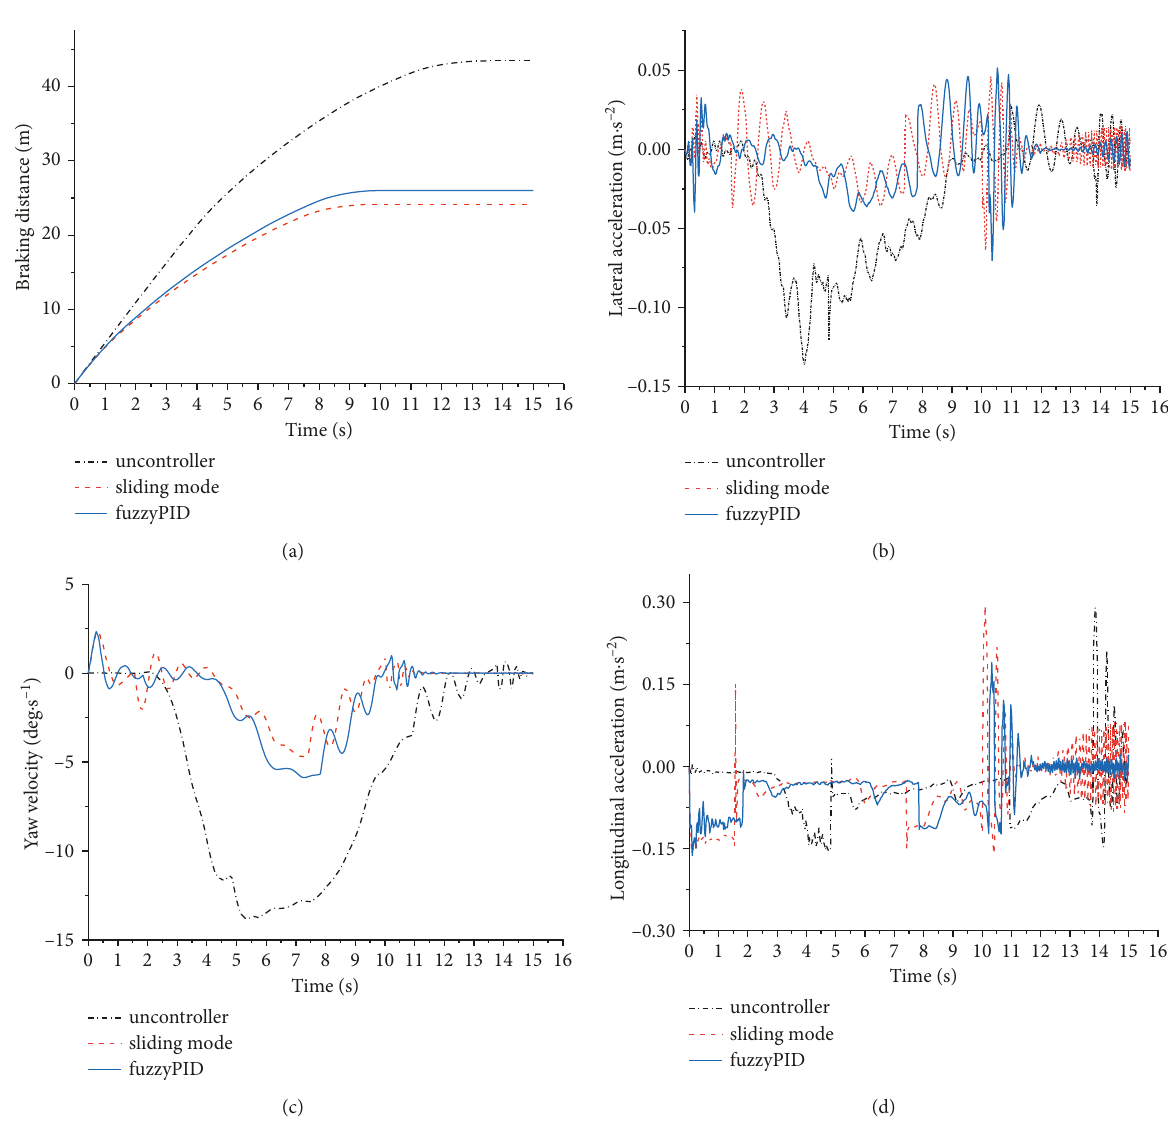
Figure 16: Simulation comparison diagram of different controls in curve driving with u � 0.5. (a) Braking distance. (b) Lateral acceleration. (c) Yaw velocity. (d) Longitudinal